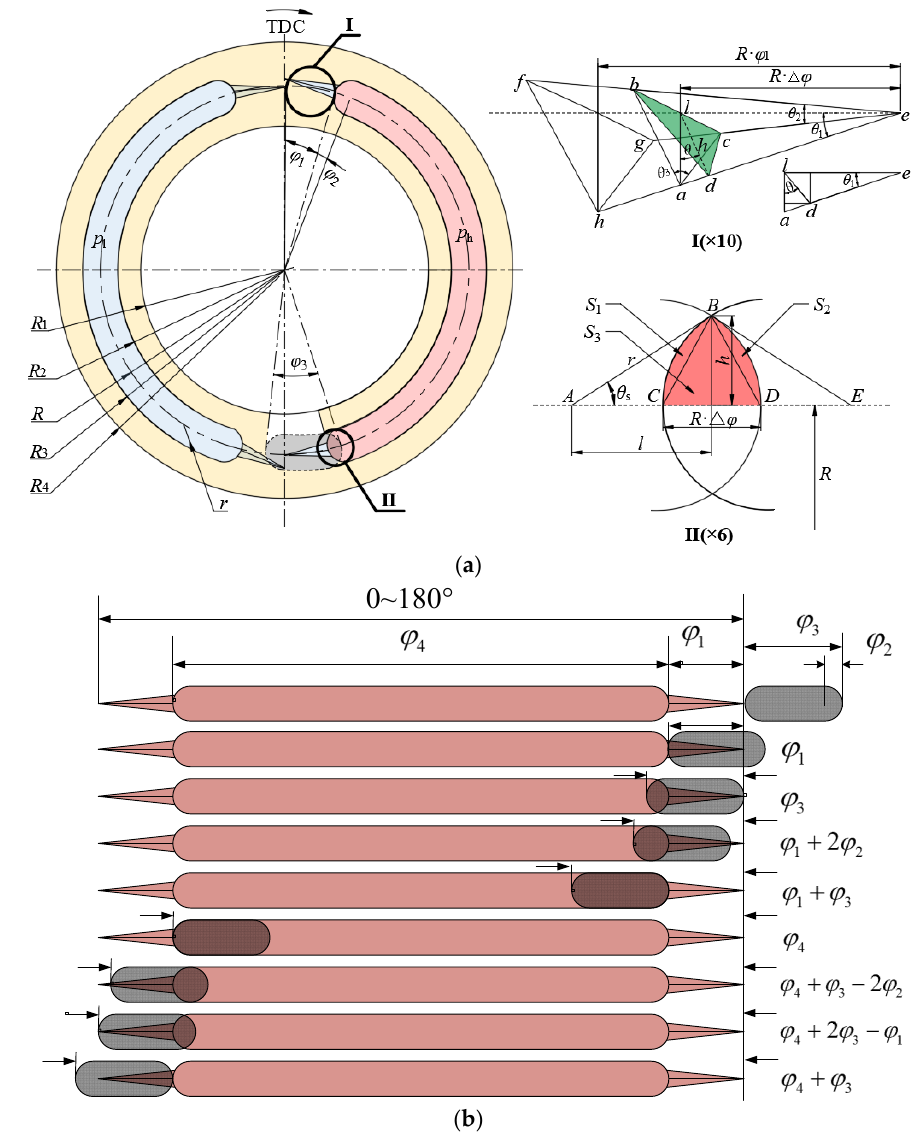
Figure 2. Schematic diagram of flow area: ( a ) Structure of piston chamber and the port window of value plate and its partially enlarged view; ( b ) Schematic diagram of piston chamber and value plate port window position.